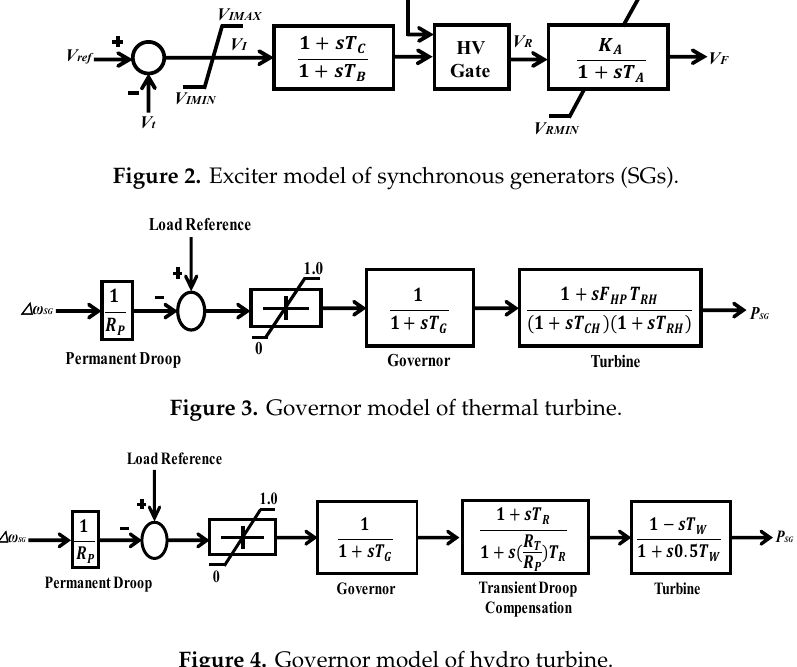
Figure 4. Governor model of hydro turbine.